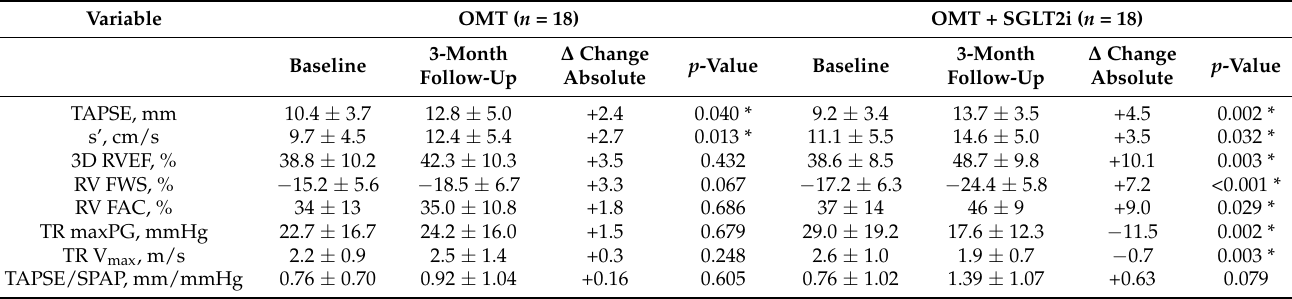
Table 3. Absolute changes in values of right-sided functional echocardiographic parameters at baseline and 3-month follow-up, stratified by the type of treatment received (OMT vs. OMT + SGLT2